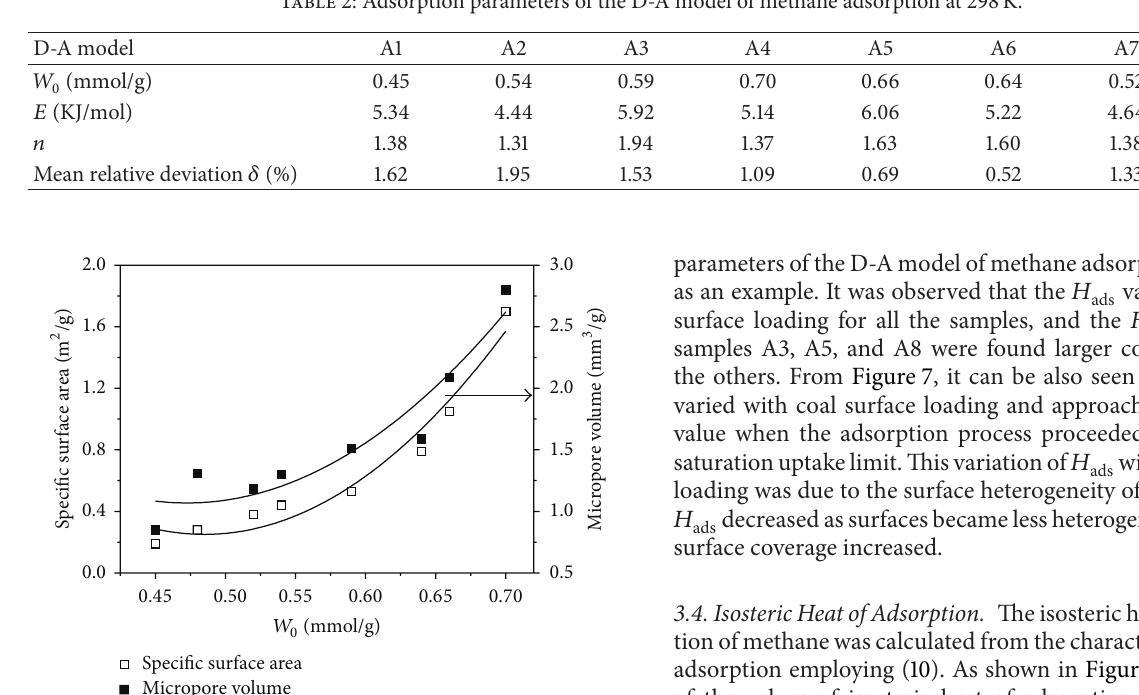
Table 2: Adsorption parameters of the D-A model of methane adsorption at 298 K.